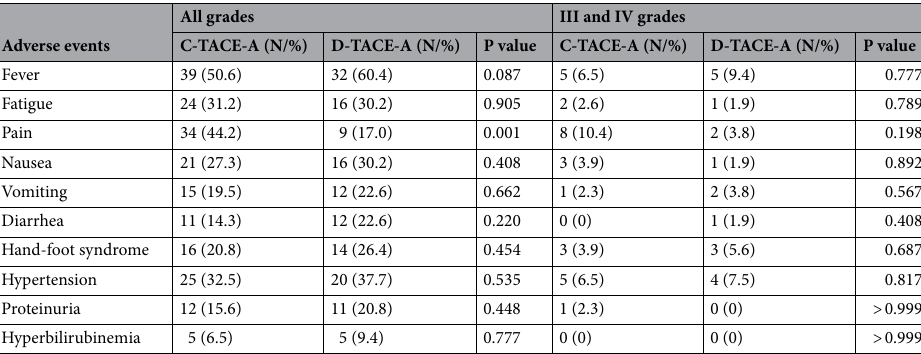
Table 7. The adverse events of patients with TACE-A before PSM.